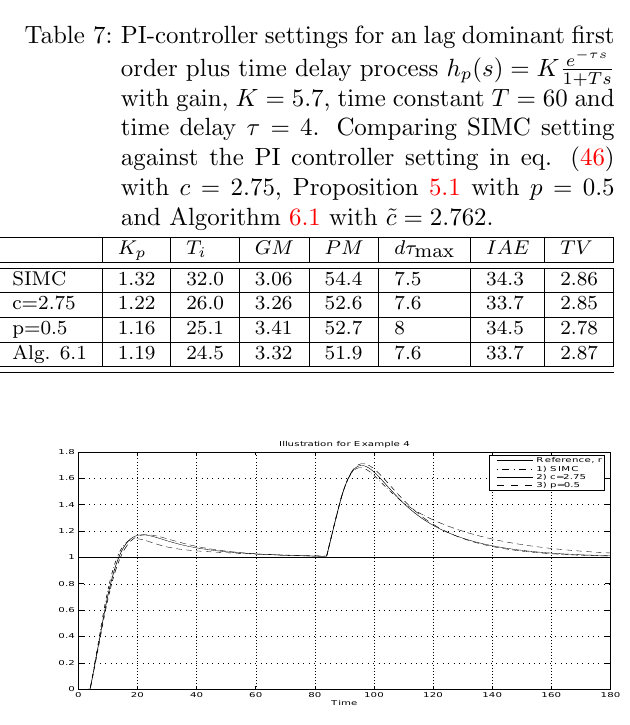
Table 7: PI-controller settings for an lag dominant first with gain, K = 5 . 7, time constant T = 60 and